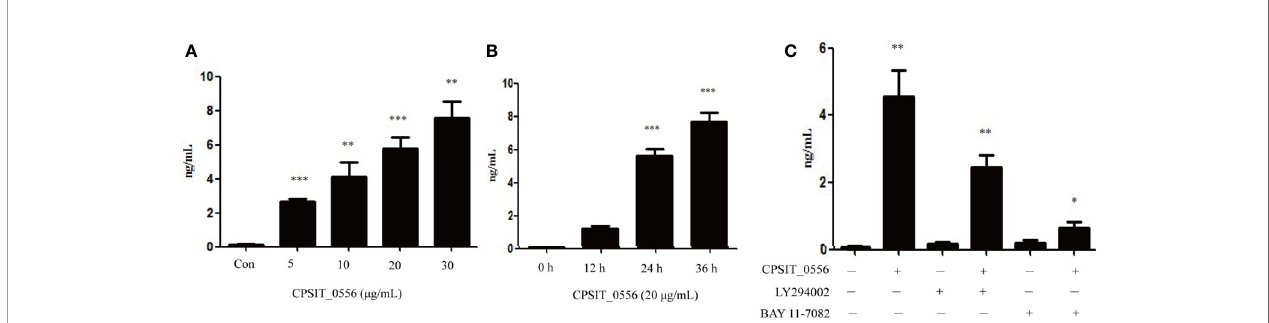
FIGURE 6 | CPSIT_0556 induced the release of IL-8 from hPMN. (A) hPMN were exposed to CPSIT_0556 at different concentrations or in medium alone for 24 h. (B) hPMN were co-cultured with 20 m g/mL CPSIT_0556 for 12, 24, and 36 h. (C) hPMN were pre-incubated with or without inhibitors of NF- k B (10 m M BAY 11- 7082) or with the PI3K inhibitor LY294002 (25 m M) for 30 min before co-incubation with CPSIT_0556 for 24 h. IL-8 levels were measured using ELISA. * P < 0.05, ** P < 0.01, *** P <